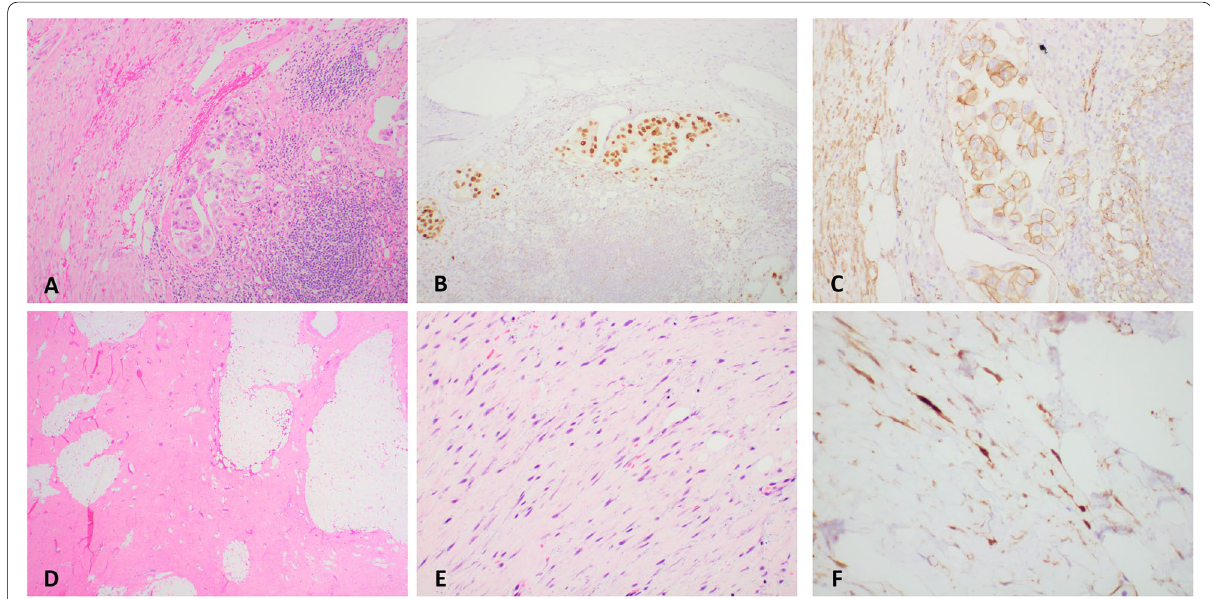
Fig. 3 Microscopic examination of the mesenteric nodule. ( A H&E, 100X) Islets of metastatic urothelial carcinoma are seen within the lymph node. The tumor cells are positive for GATA-3 ( B ) and membranous beta-catenin ( C ). A spindle cells stroma proliferation surrounding the foci of metastatic urothelial carcinoma ( D H&E, 20X; E H&E, 200), with positive nuclear beta-catenin stain ( F